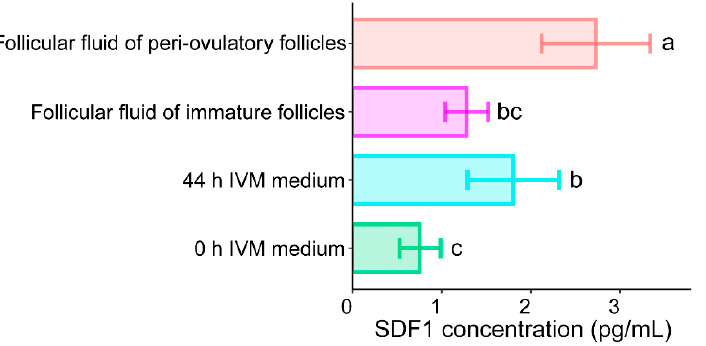
Figure 1. The SDF1 concentration in porcine oocyte IVM medium and follicular fluid. Values are presented as mean ± SD. Values labeled with different letters differ at p < 0.05.